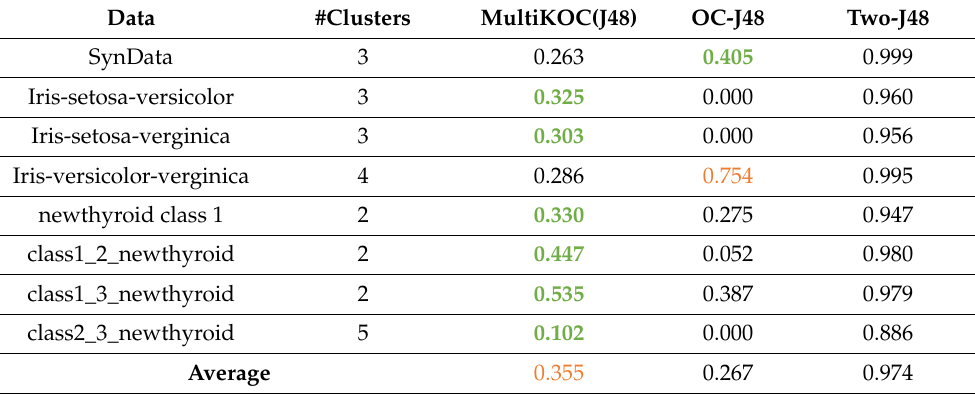
Table 2. Results summary for J48 classifier. The column #clusters is the optimal number of clusters obtained for MultiKOC.